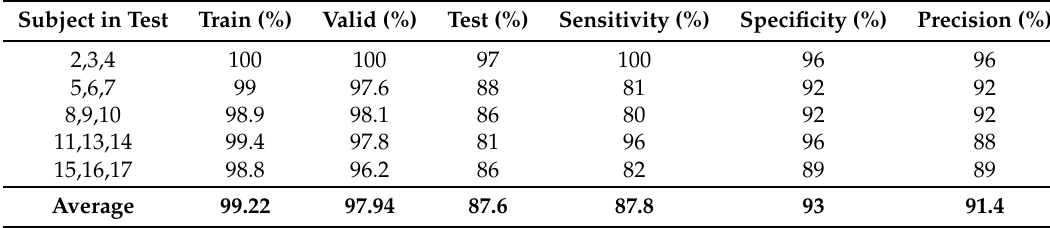
Table 9. The accuracy measures for the generic models with 20% calibration samples using frequency domain images.